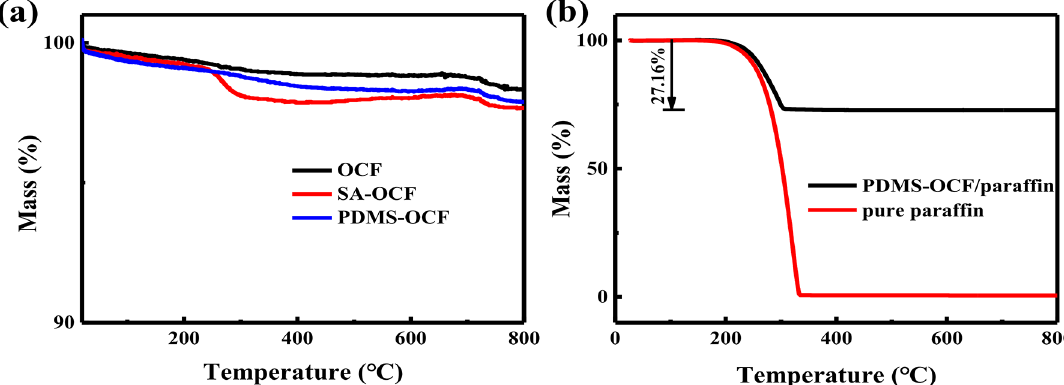
Figure 4. TGA curves of (a) OCF, SA-OCF and PDMS-OCF; (b) PDMS-OCF/paraffin and pure paraffin